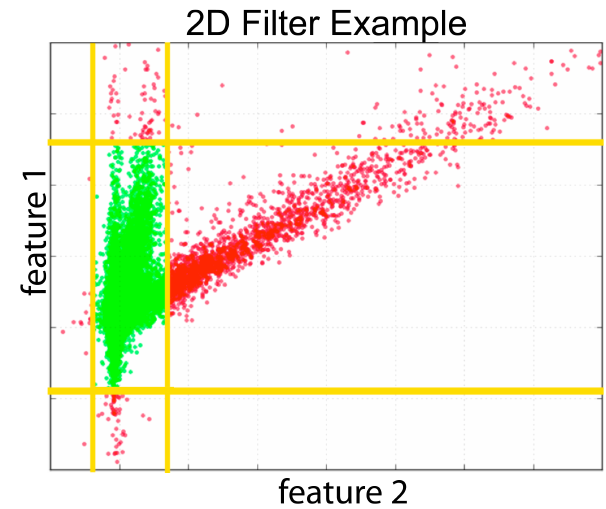
Figure 2. Two-dimensional feature example. Yellow lines represent the max and min 2 Fig. 2. Two-dimensional feature example. Yellow lines represent thresholds for each of the two sub-filters, with only data satisfying the union (green) accepted 3 the max and min thresholds for each of the two subfilters, with only by the filter and all other data (red) rejected. 4 data satisfying the union (green) accepted by the filter and all other data (red)